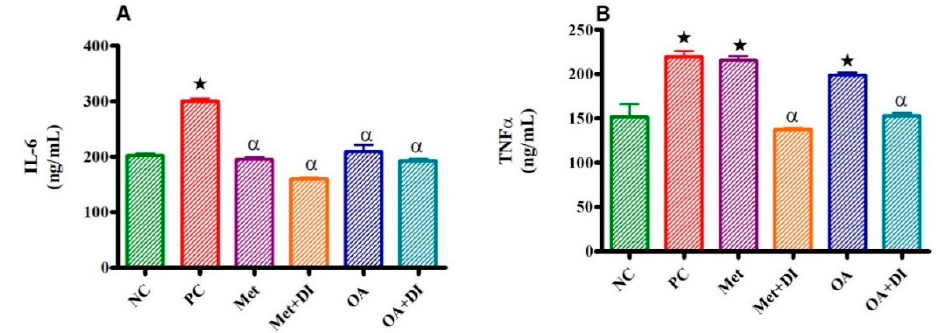
Figure 3. Effects of OA and Met ( n = 6, per group) on IL ‐ 6 ( A ) and TNF α ( B ) concentrations of rats that continued with HFHC diet and those that changed diet or had diet intervention respectively. Values are presented as standard error of mean ± SEM. = p <0.05 denotes comparison with NC; α = p < 0.05 denotes comparison with